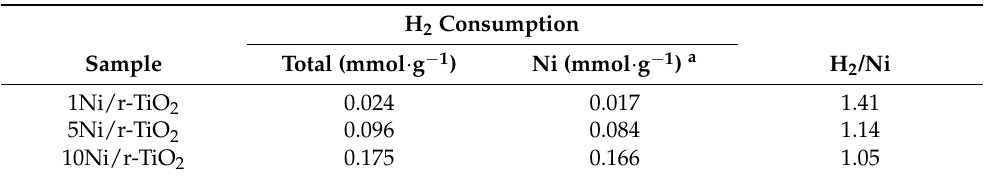
Figure 2. H 2 -TPR profiles for 1Ni/r-TiO 2 , 5Ni/r-TiO 2 , 10Ni/r-TiO 2 , and r-TiO 2 catalysts. Table 1. H 2 consumption and molar ratio of H 2 /Ni over 1Ni/r-TiO 2 , 5Ni/r-TiO 2 , and 10Ni/r-TiO 2 catalysts determined by H 2 -TPR.